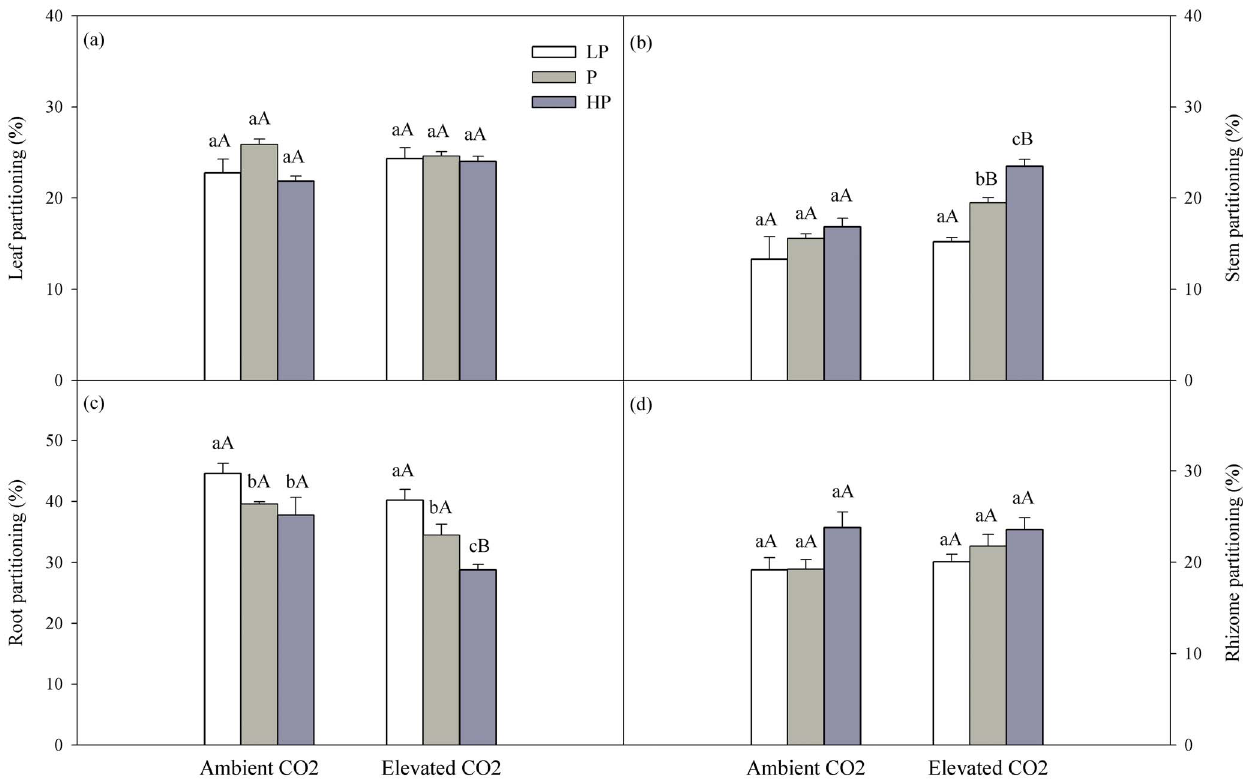
Figure 5. Effect of precipitation on biomass allocation among plant parts under two CO 2 concentrations for Leymuschinensis . Different lower-case letters indicate a significant difference among different precipitation levels, and different capital letters indicate a significant difference between the two CO 2 levels ( P , 0.05). LP, P, HP represents low precipitation ( 2 40%), normal precipitation and high precipitation ( + 40%),